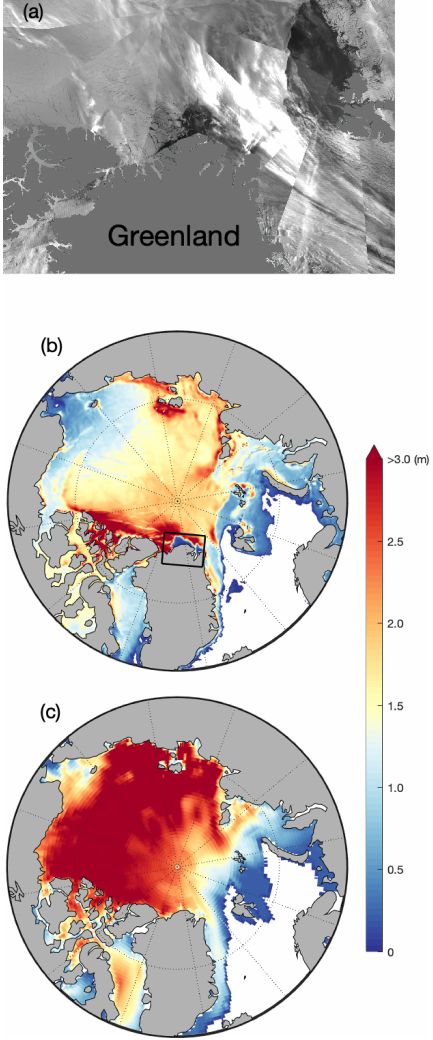
Figure 1. (a) The Visible Infrared Imaging Radiometer Suite (VI- IRS) Nighttime Imagery (Day–Night Band, Enhanced Near Con- stant Contrast) over northern Greenland on 25 February 2018 (adapted from NASA Worldview at https://worldview.earthdata. nasa.gov, last access: 9 March 2022) and sea ice thickness from (b) the RASM hindcast simulation as well as (c) CFS version 2 re- analysis over the Arctic on 25 February 2018. The rectangular box indicates the polynya